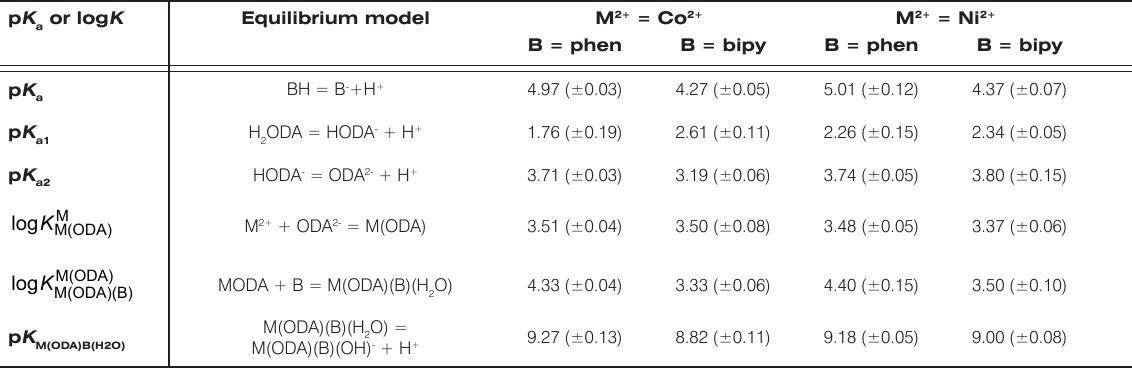
Table 1. p K and log K values (standard derivation values in parentheses) for the M-ODA-B interactions obtained by adapting the equilibrium model a to PT data. Equlibria are written in the direction that the reactions occur.